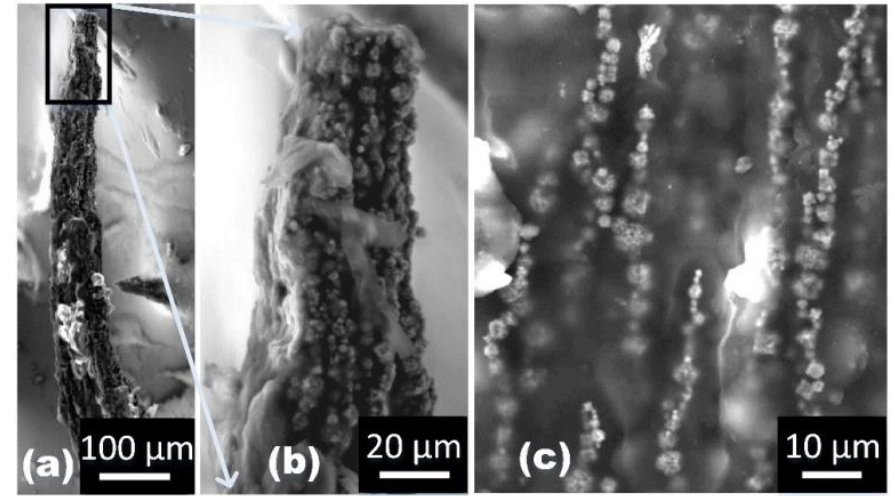
Figure 3. Typical chain structures of nickel particles in Shape Memory Polymer (SMP) matrix (3 vol% Ni). ( a ) Morphology of SMP/Ni vertical chain pillar; ( b ) Zoomed-in view of (a); ( c ) Typical morphology of nickel particles chains.